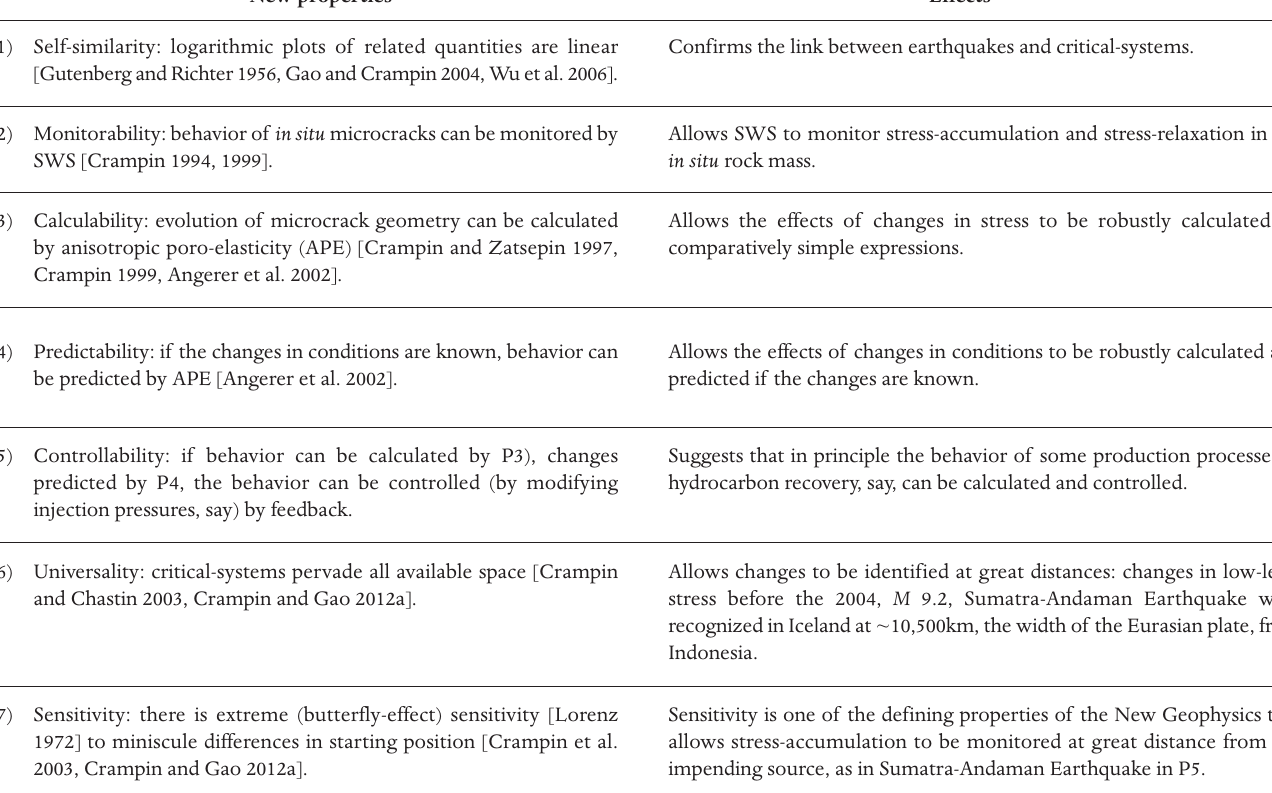
Table 2. New properties imposed on conventional sub-critical geophysics by the New Geophysics of the compliant fluid-saturated stress-aligned microcracked crust. *All these properties have been observed in situ whenever appropriate recordings are available. There are no known